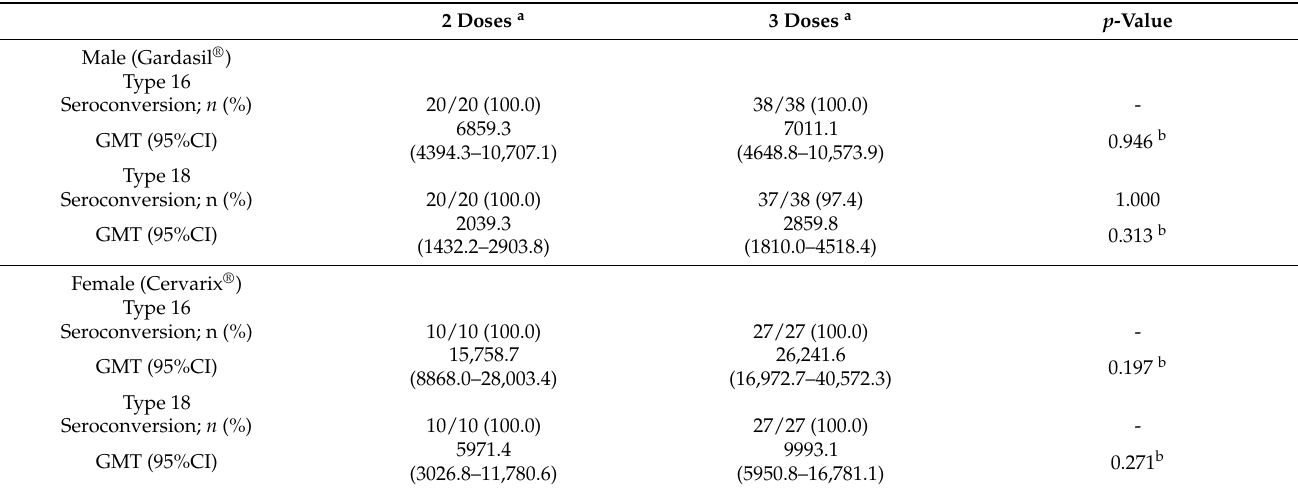
Table 2. Seroconversion and geometric mean titers (GMTs) with 95% confidence intervals (95%CIs) for HPV-16 and -18 in males and females by vaccination